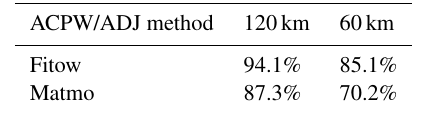
Table 5. The ratios of energy for 24h evolution through the inser- tion of the CNOPs from the ACPW algorithm and ADJ method into the initial